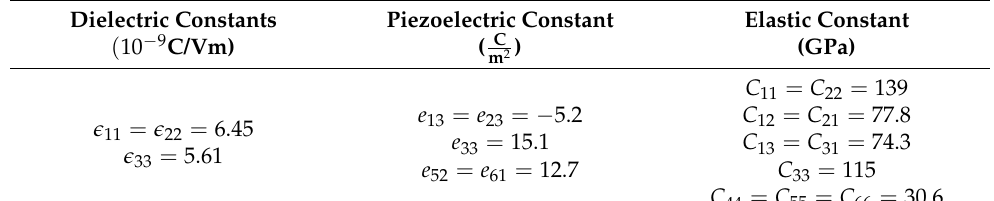
Table 2. Piezoelectrical properties of the PZT ring [14]. Table 1. Mechanical and geometric parameters of the piezoceramic vibrating mesh atomizer re- ported in References [6,20].